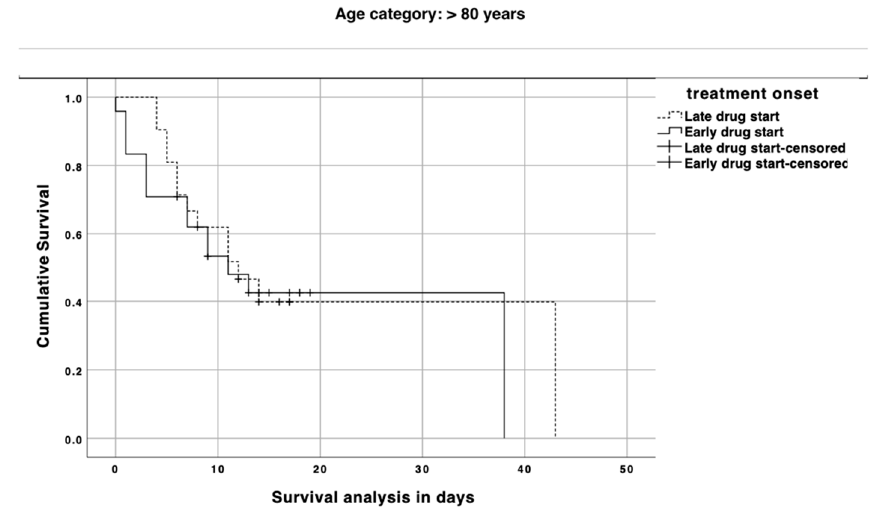
Figure 2. Survival analysis in COVID-19 patients with >80 years comparing those who started the drug within 6 days (straight line) or later (dashed line) from symptom onset. A vertical symbol on lines represents censored